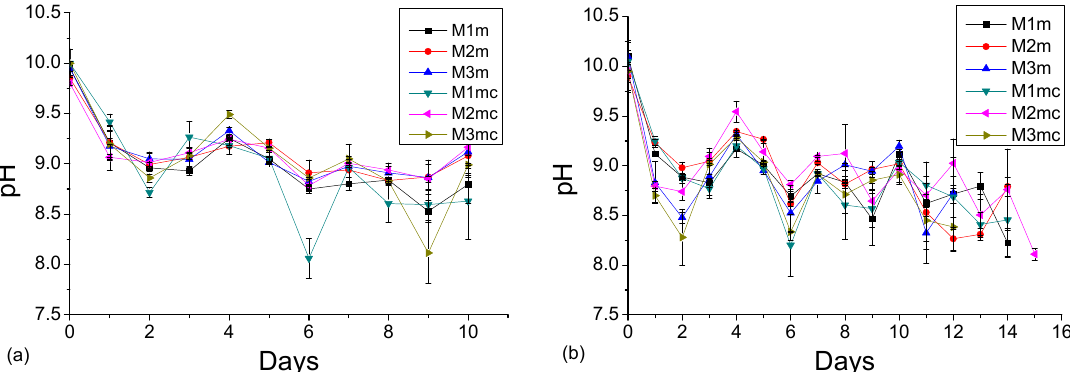
Figure 7. Surface pH values of the concrete specimens sprayed daily with 17% of the reaction’s stoichiometry: ( a ) thin layer, and ( b ) thick layer of coating. The data points and the error bars denote the mean and the standard deviation, respectively.